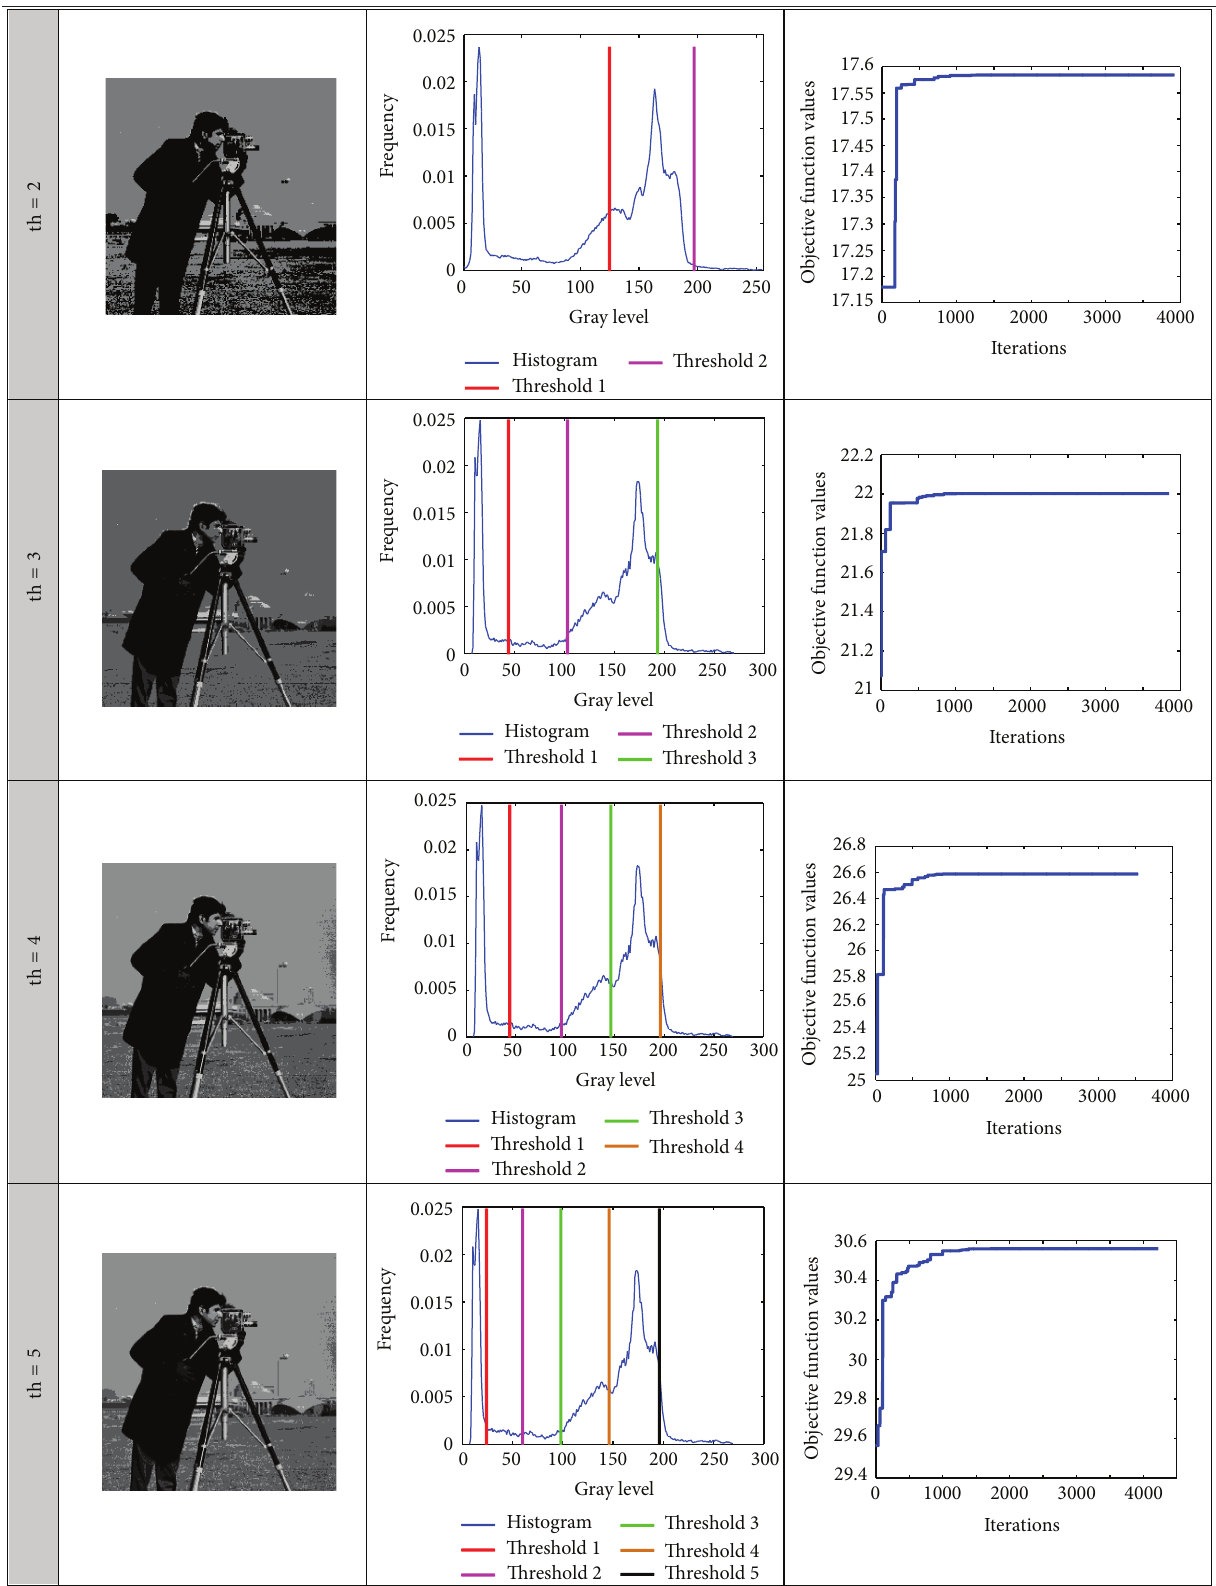
Table 10: Results after appling the HSMA using Kapur’s over the Camera man